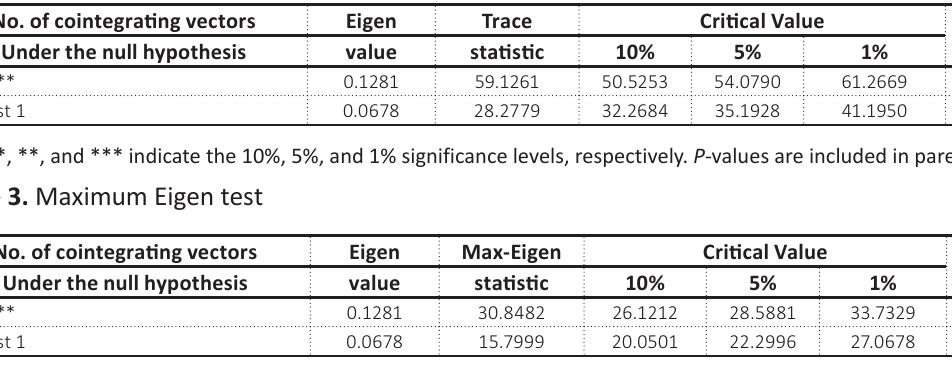
Table 2. Johansen cointegration test